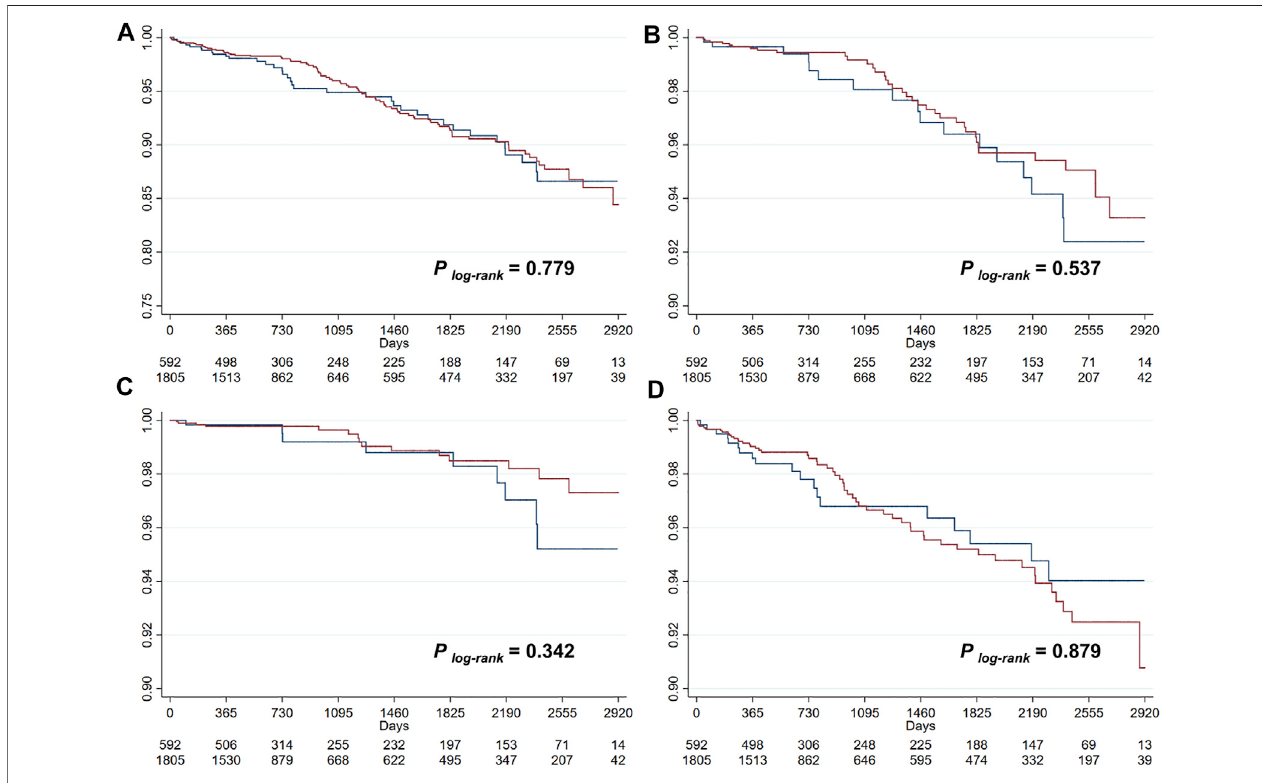
FIGURE 1 | Kaplan-Meier survival curve analysis for the primary outcome (A) , all-cause death (B) , cardiac death (C) , and recurrent myocardial infarction (D) .